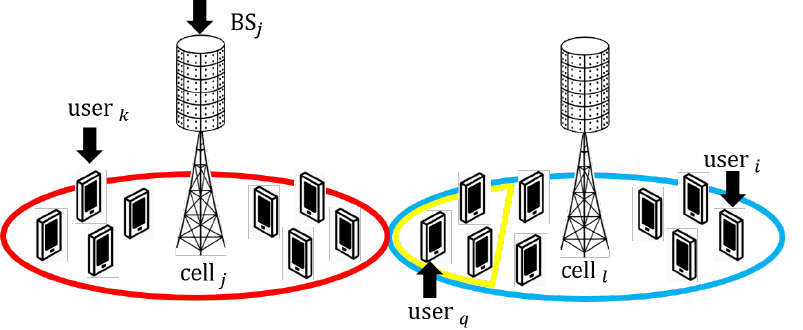
Figure 1. Intra-cell interference is caused during up-link transmission between user k and any other user in cell j (red circles). Inter-cell interference is caused by users in the neighbouring cell (blue circle). Users within the yellow circle cause dominant inter-cell